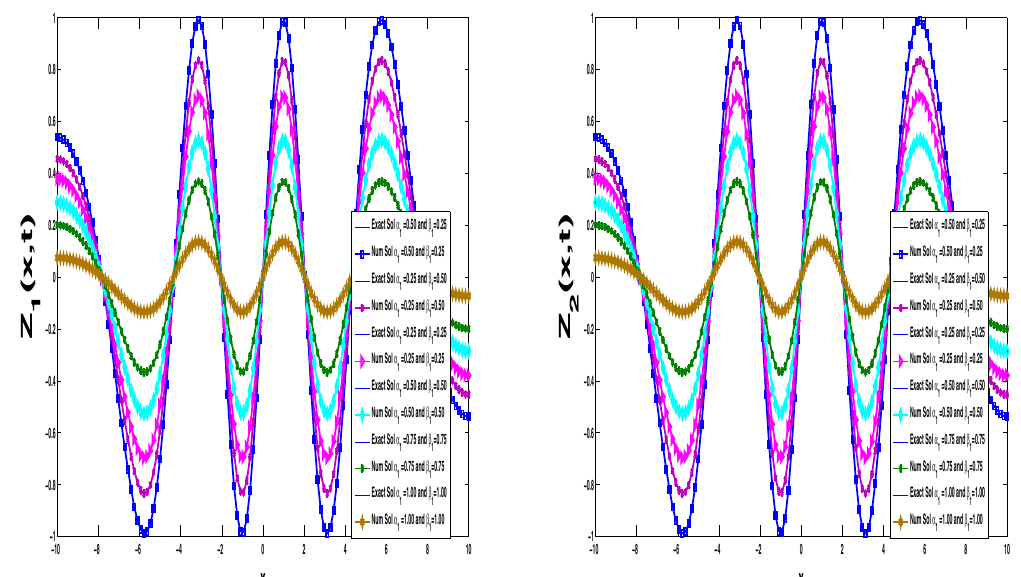
Fig. 2 Numerical and exact solutions of Z 1 ( x , t ) and Z 2 ( x , t ) for example 1 with different α 1 and β 1 and time T = 0 . 005 Table 2 Numerical solutions of proposed method at time T = 1 . 00 with different α 2 β 2 and grid points M for example 2 M α 2 = 0 . 25 ,